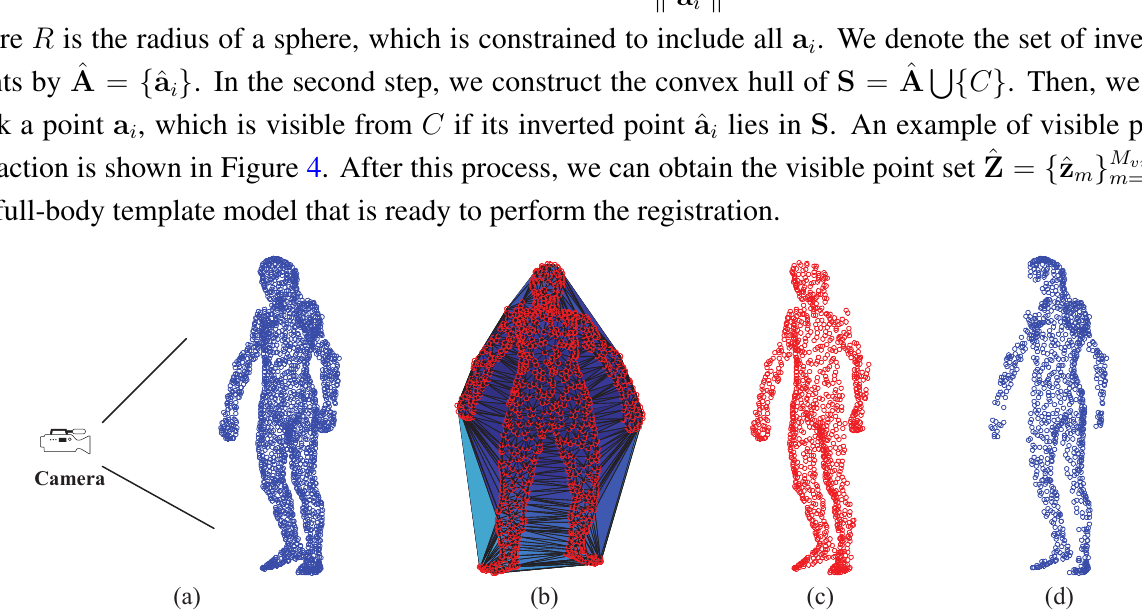
Figure 4. ( a ) Relative position between the camera and the 3D template; ( b ) The inverted points lie in the convex hull; ( c ) The extracted visible points; ( d ) The invisible